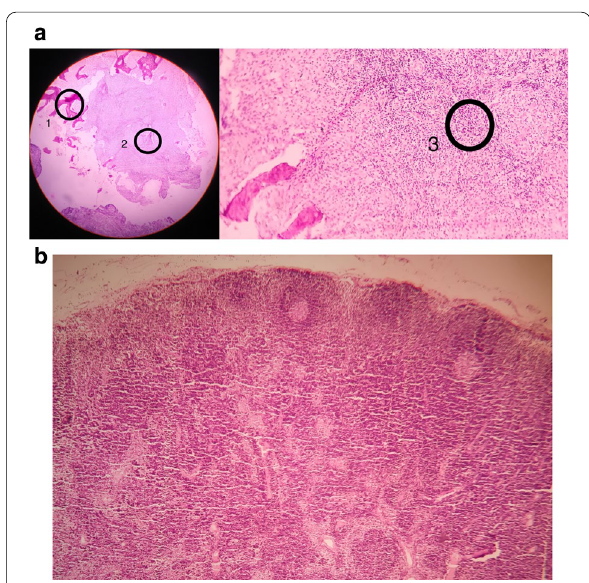
Fig.6 a High resolution histopathology images show 1. Bone trabecule, 2. Inflammatory infiltrate, mixed inflammation acute and chronic, 3. The medullary space tissue shows fibrosis with granulation tissue formation. b Lymph node showed only reactive changes